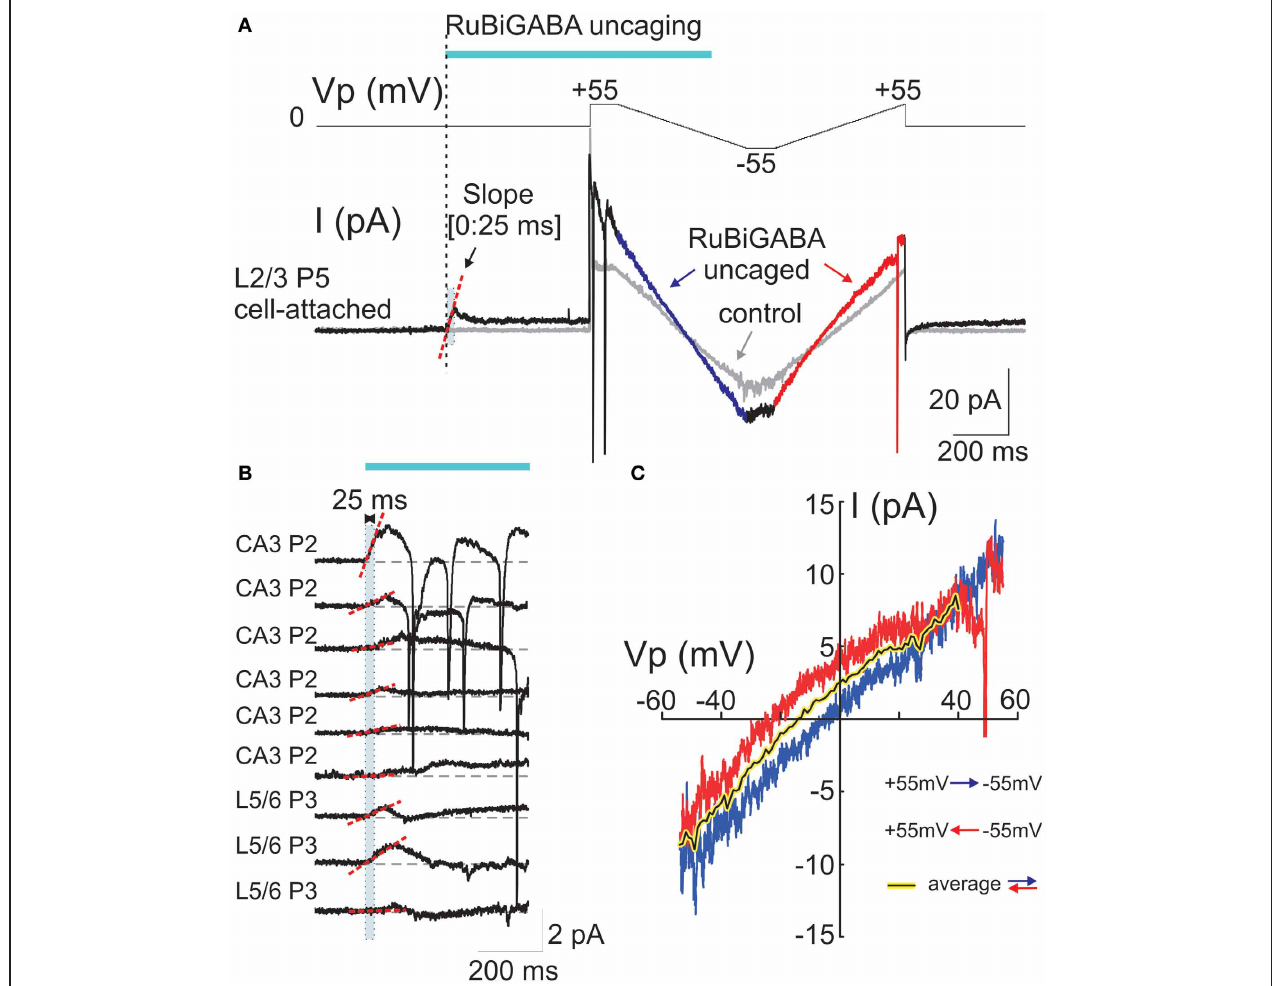
at resting membrane potential ( Vp = 0mV) in hippocampal (CA3) and cortical (L5/6) neurons of P2-3 rats. Initial (0:25ms) slopes are indicated by red dashed lines. Note the inward direction of the initial response slopes in all recorded cells. (C) Current-voltage relationships of the currents activated by uncaged GABA, obtained after subtraction of control ramps from the responses after RuBi-GABA uncaging during hyperpolarizing-to-depolarizing ramps (blue) and depolarizing-to-hyperpolarizing ramps (red). Note a difference in the reversal potentials of these curves that indicates a hysteresis of the GABA conductance reversal potential. The black-on-yellow curve is a smoothed average of the current-voltage relationships obtained during bidirectional